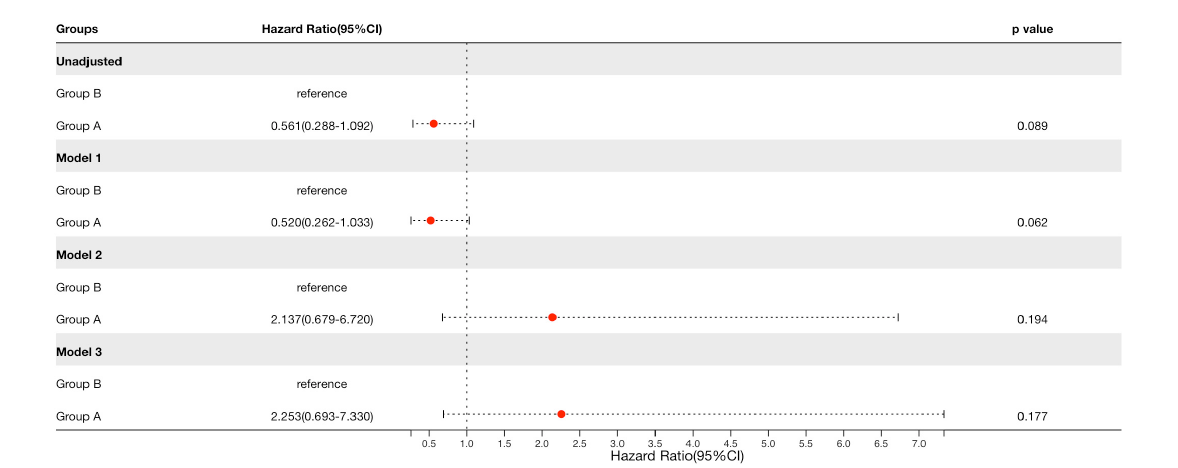
mild subgroup: 14 (60.9%)/1 (4.3%)/7 (30.4%)/1 (4.3%)